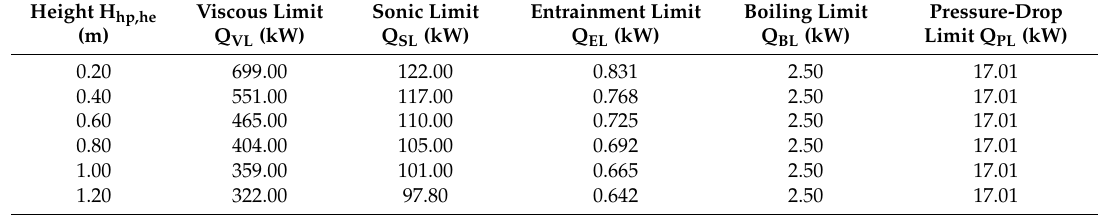
Table 4. Impact of the condenser-to-absorber height difference.